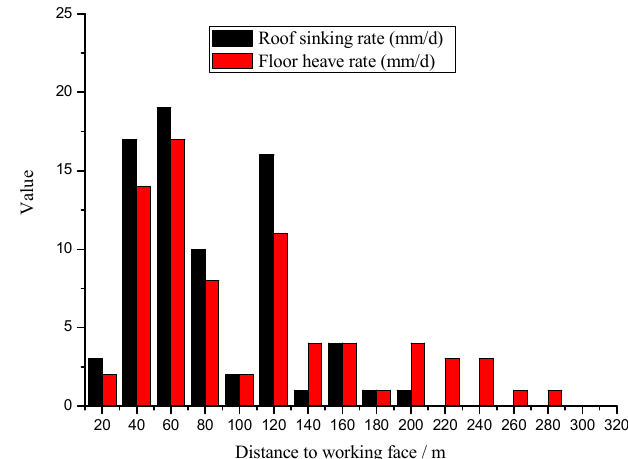
Figure 18. Vertical convergence rate of GERRC.